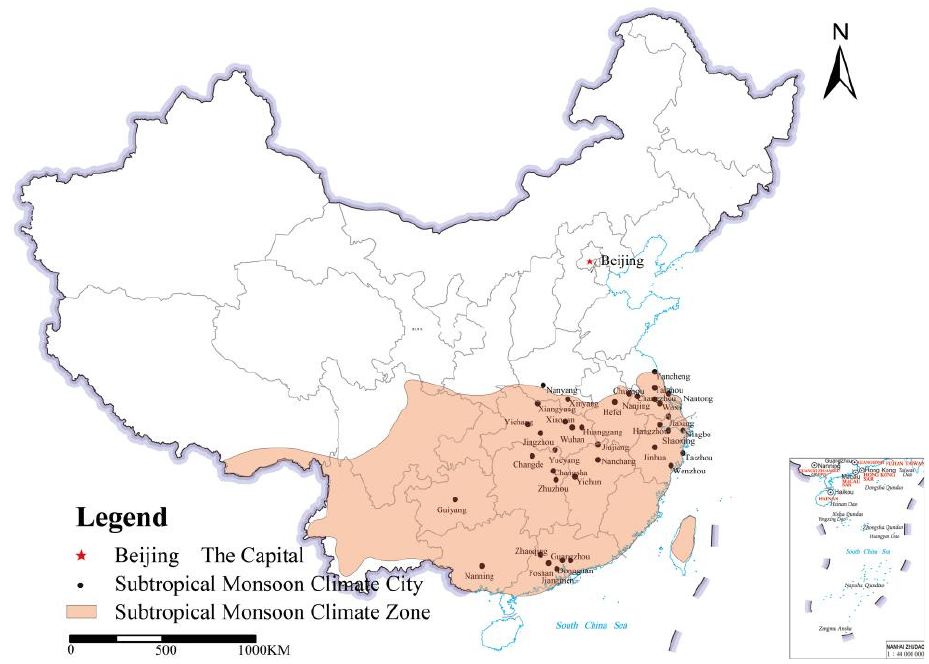
Figure 5. Distribution map of the selected 37 cities.